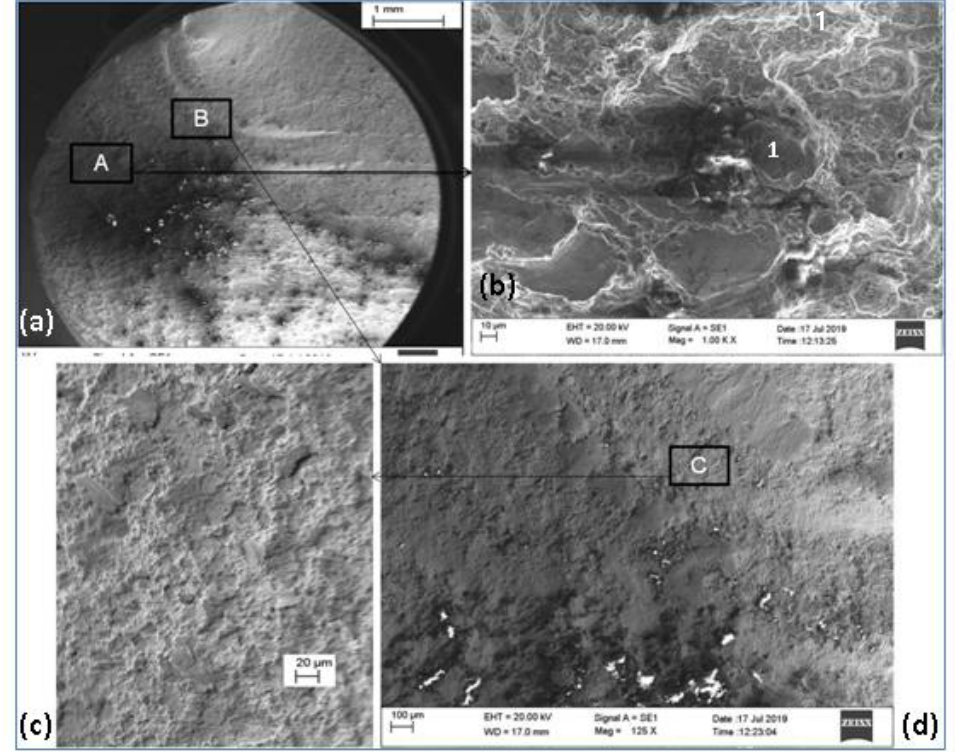
Fig. 3: SEM fractographs of failed bolt shank in acetone cleaned condition